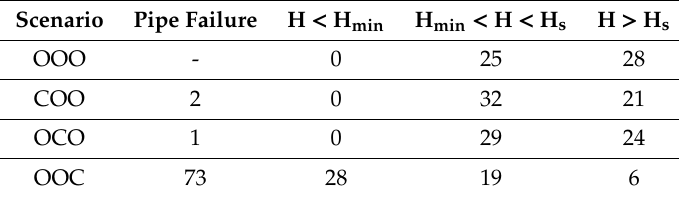
Table 1. The analysis results in steady-state conditions.